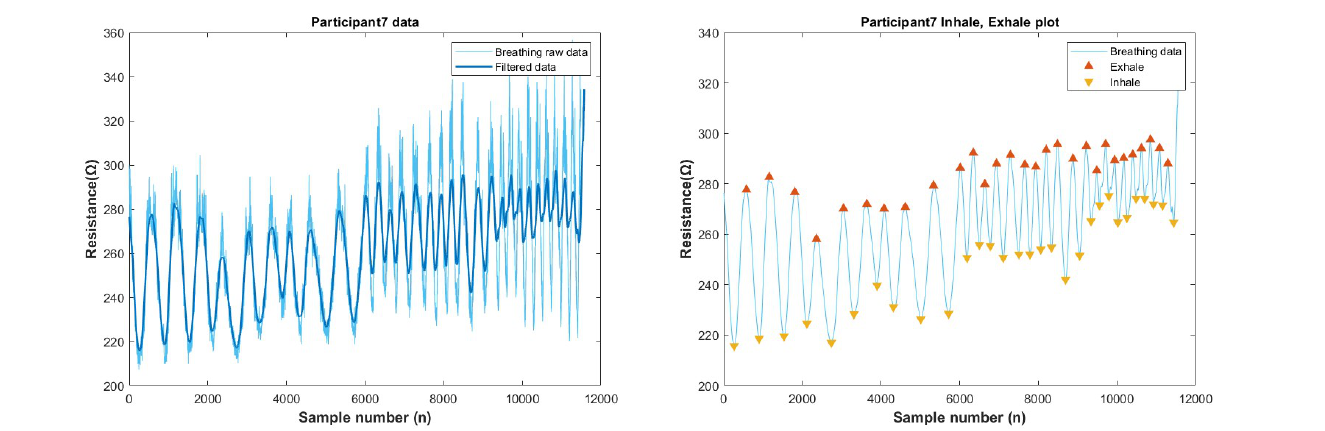
Figure A21. Breathing Test data of Participant number-6.